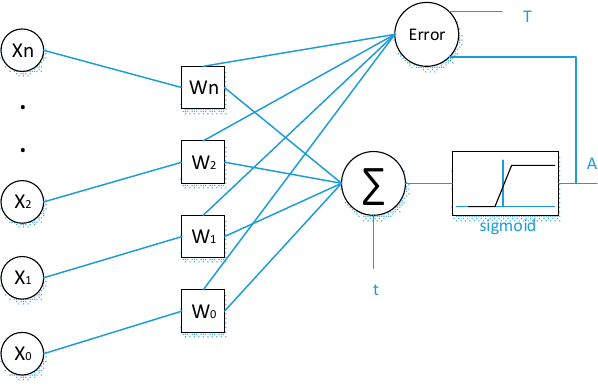
Figure 1. Illustration of the neural network approach .